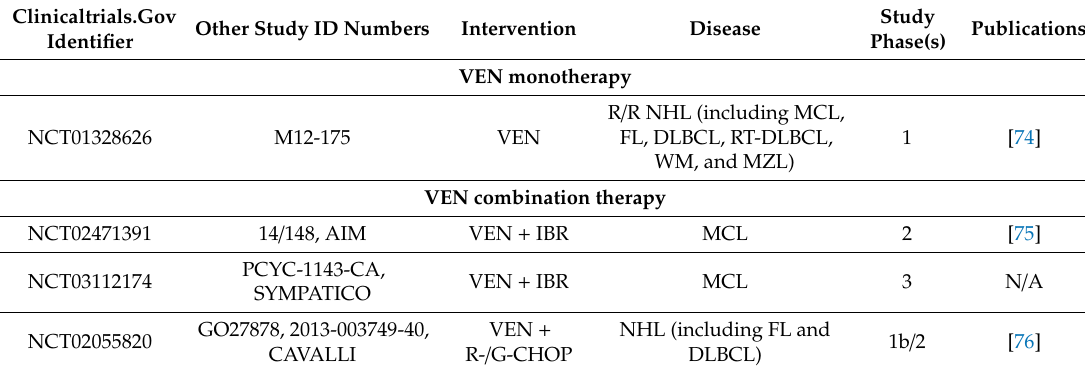
Table 2. Selected clinical trials of venetoclax in non-Hodgkin lymphomas